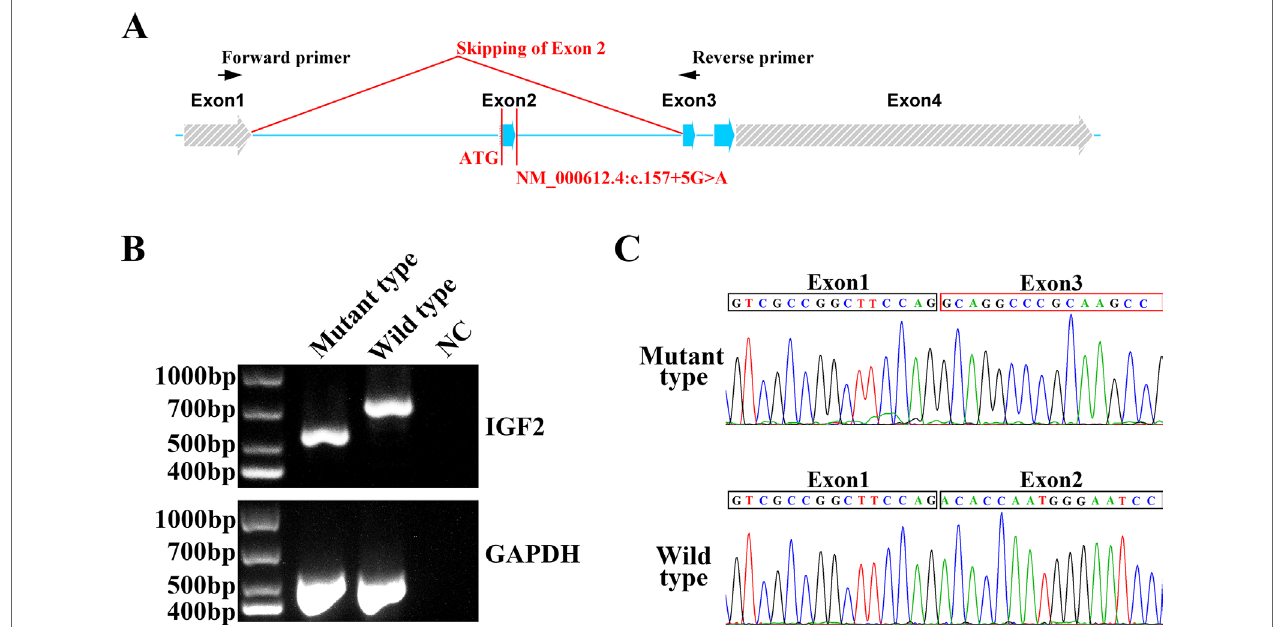
FIGURE 2 | In vitro functional analysis of IGF2 splicing variant. (A) The IGF2 gene was consisted with four exons. The NM_000612.4: c.157+5G>A variant was in intron 2. The AUG initiation codon of IGF2 was in exon 2. The RT-PCR primers were designed for exon 1 and exon 3. (B) Agarose gel electrophoresis of the RT-PCR products from the proband and the healthy control. The PCR of the mutant type mRNA from the proband produced a truncated electrophoretic band of about 600 bp. GAPDH was used as an internal control. (C) Sanger sequencing of mutant type and wild type PCR products. Exon 2 skipping was clearly observed in mutant type mRNA, while the normal mRNA sequence was observed in the wild